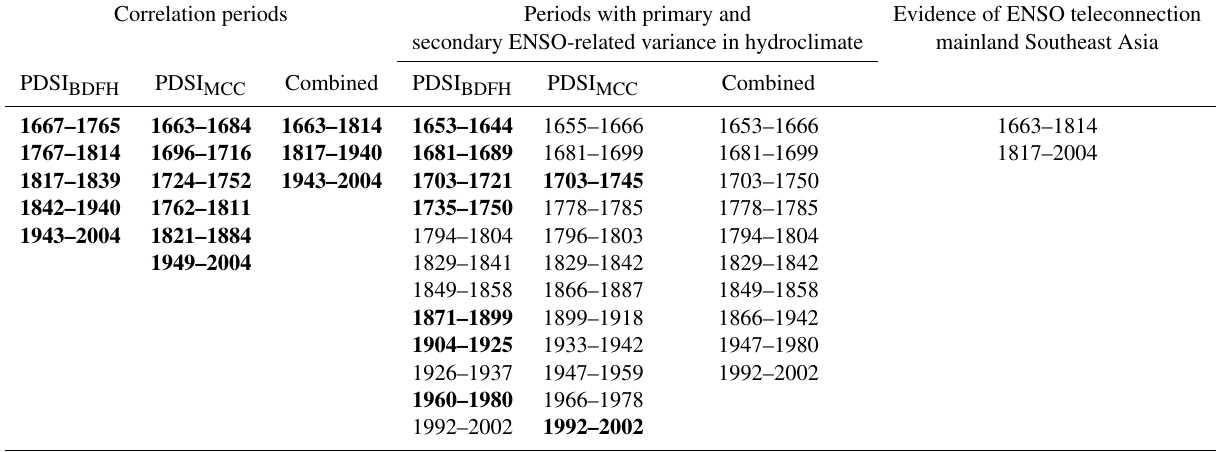
Table 4. Periods with evidence of ENSO teleconnection in March–May hydroclimate of mainland Southeast Asia over the period of 1650– 2004. “Correlation periods” refer to periods with statistically significant correlation in moving-window correlation analysis (Fig. 4), and “periods with primary and secondary ENSO-related variance in hydroclimate” refer to periods when ENSO had stronger influence on hydro- climate according to wavelet analyses (Figs. 5–6). Statistically significant periods ( p <0.05) are in bold. Correlation periods Periods with primary and Evidence of ENSO teleconnection secondary ENSO-related variance in hydroclimate mainland Southeast